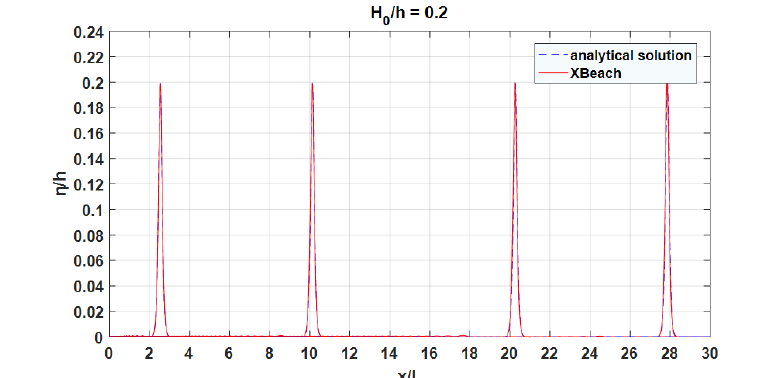
Figure 1. Propagation of a solitary wave on a frictionless flat bottom: snapshots of free-surface profile at various time stamps. Solid: numerical results by XBeach [20]. Dashed: analytical formulation for solitary wave. H 0 and h denote the initial wave height and the water depth, respectively, and L is the wavelength. The initial wave nonlinearity is ε = H 0 / h = 0.2 and the spatial resolution is 100 grids per wavelength.